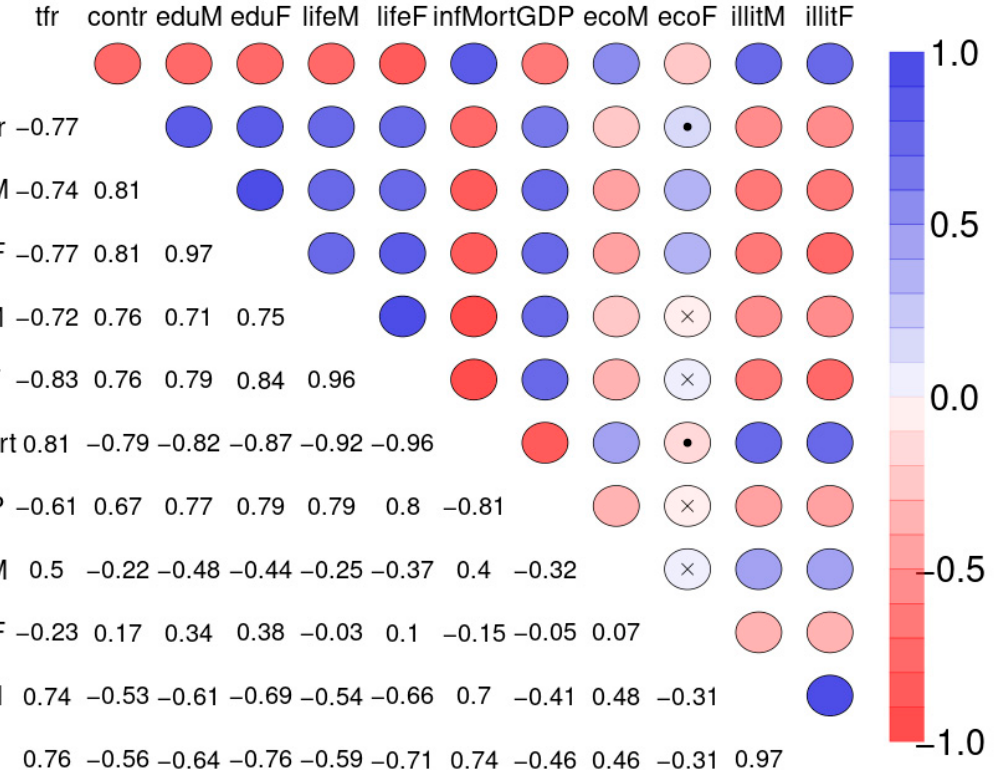
Figure 9. Number of spurious edges within networks created from 20 scrambled ( left ) and 20 normally distributed random data sets ( right ) to indicate falseness. SNHA using Pearson (snha.p) and Spearman (snha.s) correlation resulted in the smallest number of false random edges (less agreement, Holm adjusted p < 0.05, confirmed by Wilcoxon test). The number of edges was smaller than predicted by correlation threshold of |r| > 0.1 (R 2 > 0.01) and linear model building using forward selection with predicted R 2 value of at least 1% and 10% (lm 0.01, lm 0.10). The number of edges created by snha.p and snha.s (threshold |r| > 0.1), did not differ significantly.